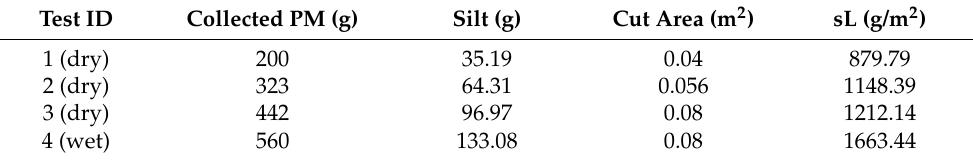
Table 7. Comparison of silt loading values associated with cutting